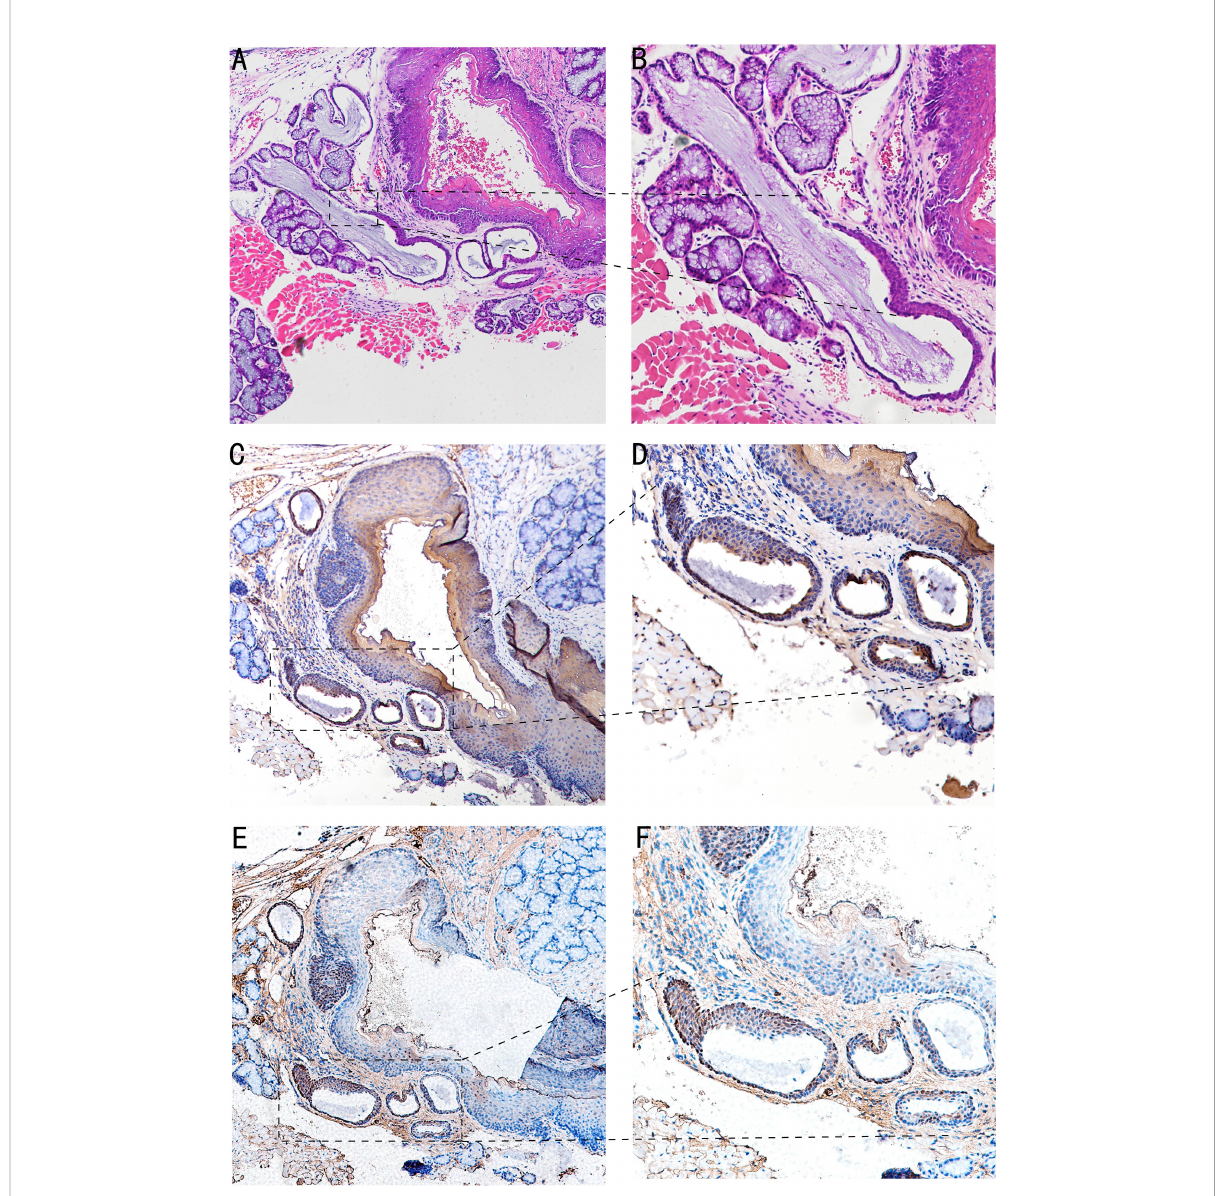
FIGURE 2 Image of BOT in the 4-NQO-treated mouse model of oral squamous cell carcinomas at 30 weeks. (A, B) HE staining of Von Ebner ’ s glandular duct in mouse BOT; the dotted line denotes the transformation zone (A,×4; B,×10). (C, D) The CK7 expression of Von Ebner ’ s glandular duct in mouse BOT; dotted line can indicates squamous metaplasia and dilatation of branching ductus (C,×4; D,×10). (E, F) The TSC22D1 expression of Von Ebner ’ s glandular duct in mouse BOT; the dotted line denotes squamous metaplasia and dysplasia of ductal epithelium, and rarely positive in complete squamous metaplasia of the anterior segment of ductal epithelium.TSC22D1 was consistently positive in the dysplasia of ductal epithelium ( E ,×4; F